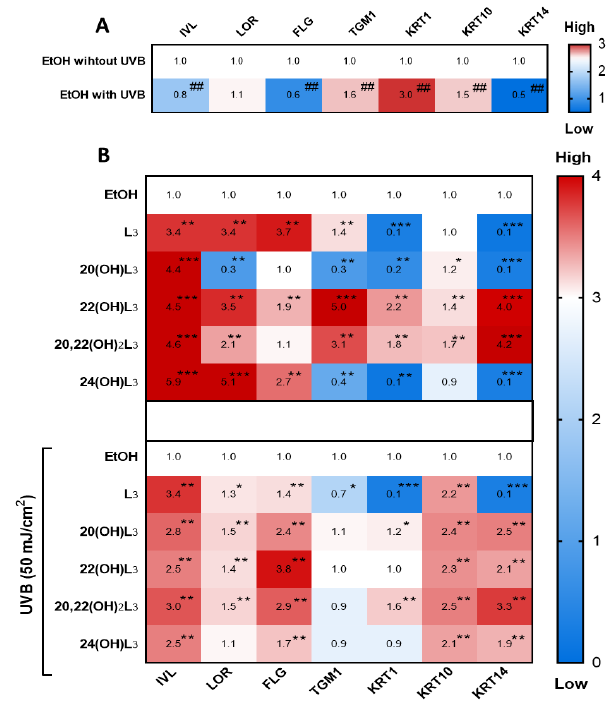
Figure 7. Heat map presentation of the changes in the expression of genes indicative of keratinocyte Fig. 7 Heat map presentation of the changes in the expression of genes indicative of di ff erentiation. Gene expression was normalized relative to β -actin, cyclophilin, and GAPDH mRNA. ( A ) Comparison of ethanol-treated control cells with non-irradiated and irradiated cells. ( B ) Treatment keratinocyte differentiation. groups compared to ethanol-treated control cells without or with UVB irradiation. Each vertical row represents expression of the same gene product, and each horizontal row represents each sample tested. The fluorescence range, from high (red) to low (blue), is indicated by the colored bar and reflects the degree of fluorescence intensity / gene expression. The statistical analysis between the non-irradiated control and UVB-irradiated cells was done by Student’s t-test, and between lumisterol-treated cells and ethanol control cells by one-way ANOVA with Dunnett’s multiple comparison test. ## p < 0.01 versus non-irradiated control cells, and * p < 0.05, ** p < 0.01, and *** p < 0.001 versus ethanol control cells, n =